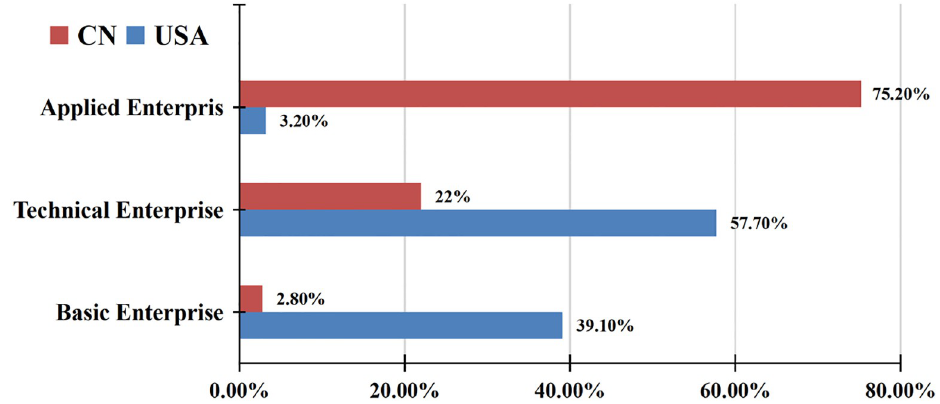
Fig 1. Distribution of AI enterprises in China and the United States. (Data source: China’s New Generation AI Technology Industry Development Report (2019), Evergrande Research Institute).